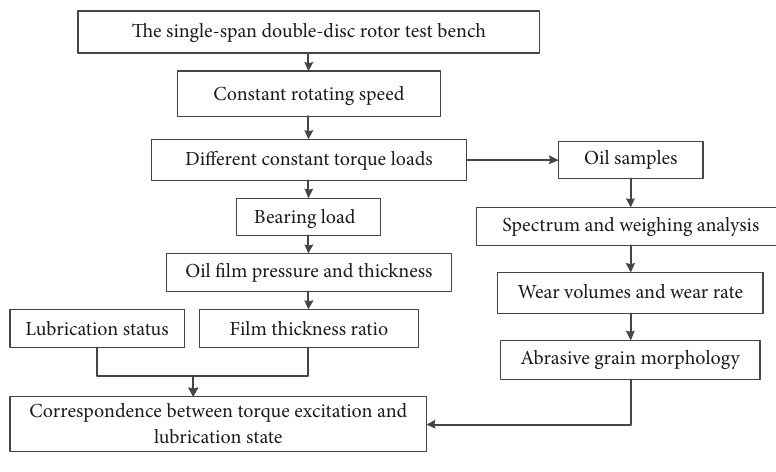
Figure 2: Technical route. Table 1: The performance parameters of the sliding bearing, shaft, and lubricating